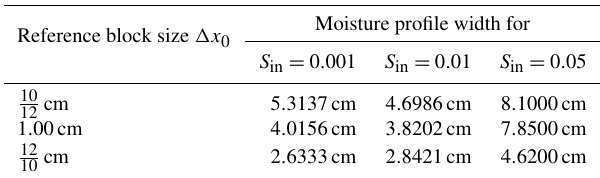
Table 1. Parameters used to reproduce the experiments of Bauters et al. (2000). Parameters for 20 / 30 sand were adopted from Schroth et al. (1996) and DiCarlo (2004).